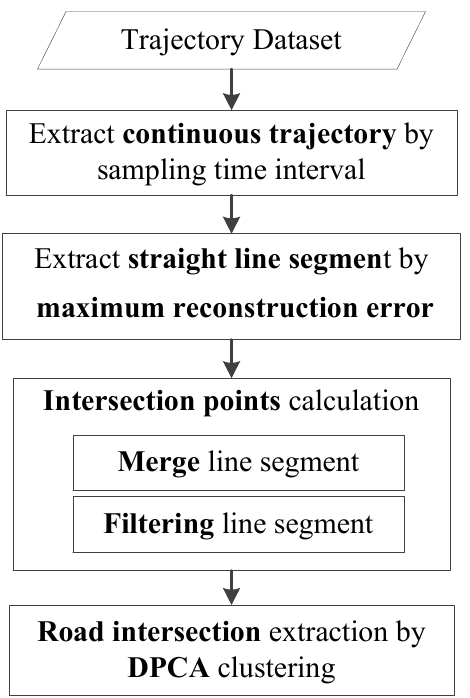
Figure 1. The workflow for extracting road intersections.